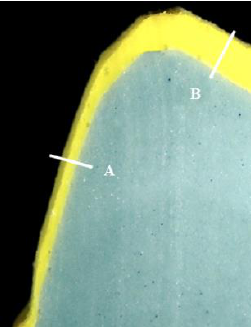
Figure 10. Internal fit of PFM dental single restoration at × 100 magnification. A: axial internal fit, B: occlusal internal fit.